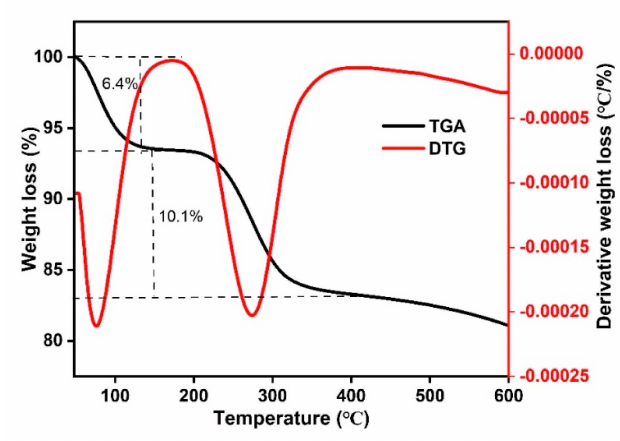
Figure 7. TGA and DTG curves of the OMSC